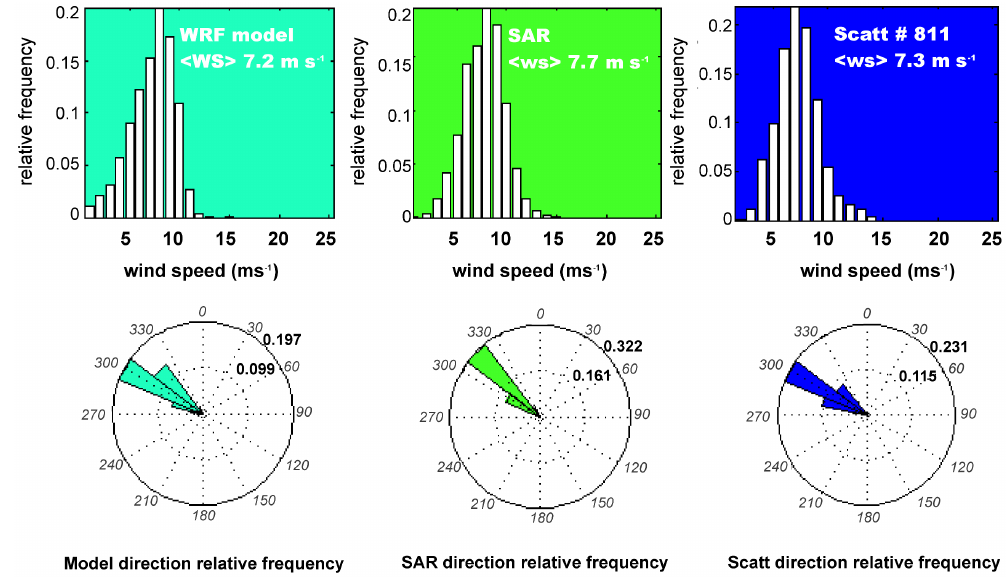
Figure 4. Frequency distributions of wind speeds (top) and wind directions (bottom) from WRF (left), ASAR (middle) and QuikSCAT (right) after resampling at 0.05 ◦ by 0.05 ◦ .